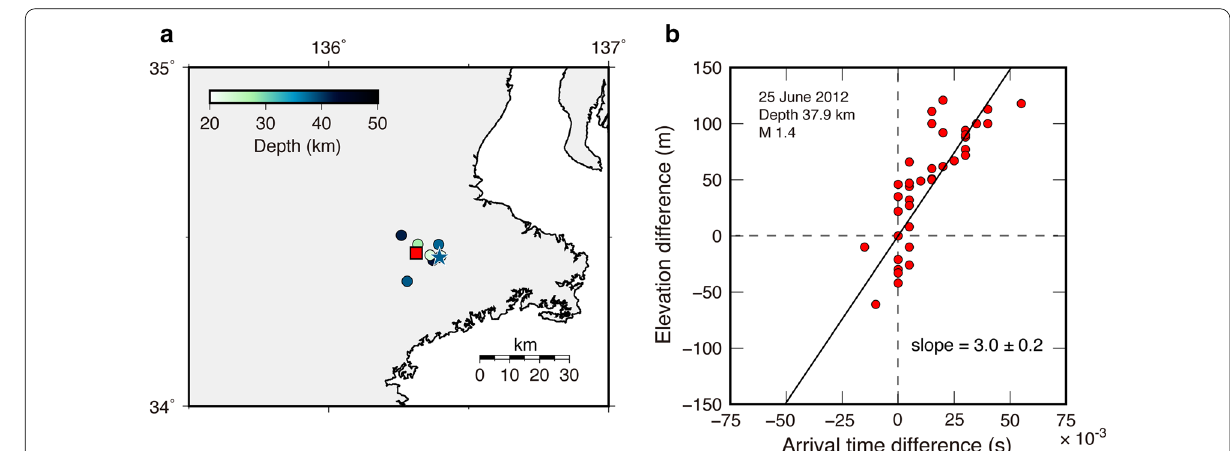
Fig. 2 a The distribution of epicenters of regular earthquakes (circles and star) and the location of the array network (red square). The epicenters are colored according to their depth. b Plot showing the relation between the arrival time differences and the elevation differences for the earthquake shown by the star in ( a ). Black line shows a linear regression line determined by the least-squares method with a constraint of passing through